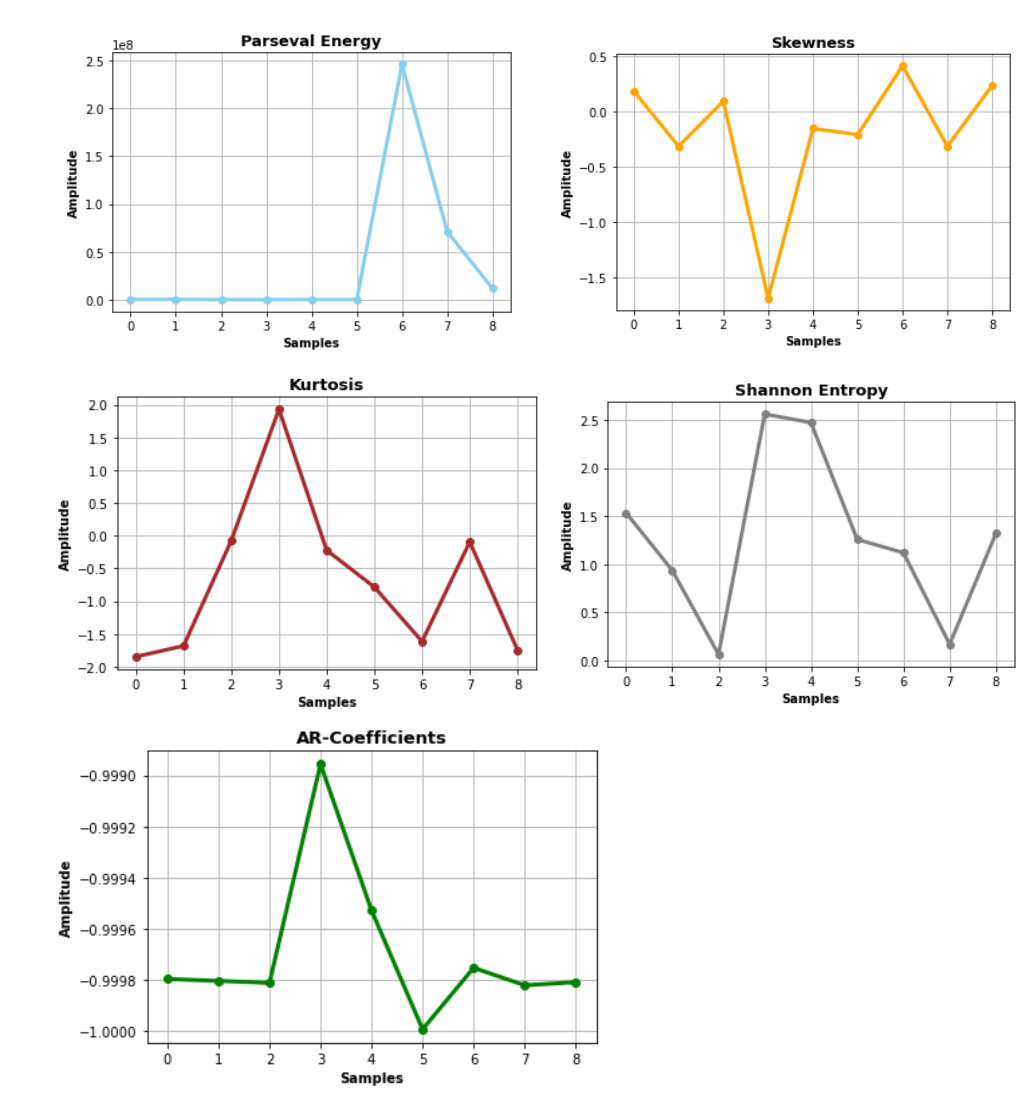
Figure 5. Feature plot for Parseval energy, skewness, kurtosis, Shannon entropy, and AR-coeffi- cients.